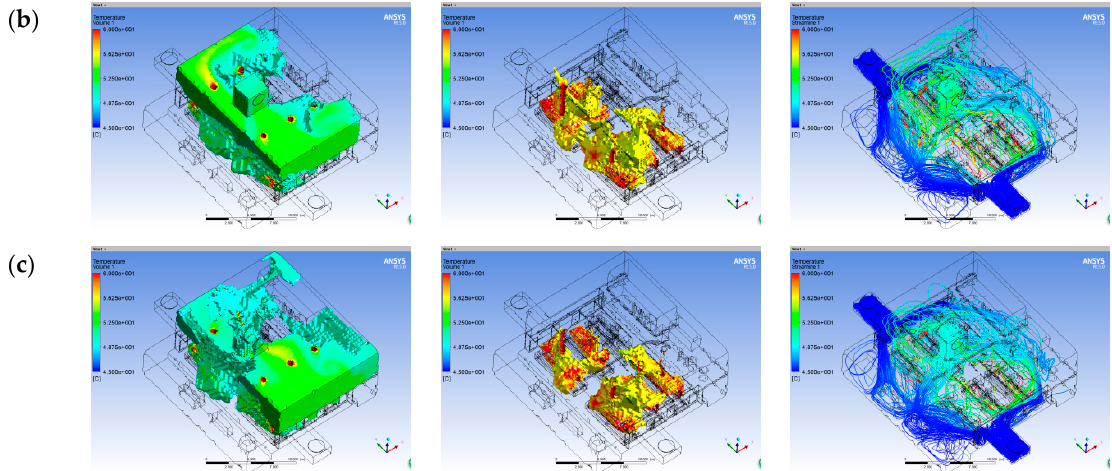
Figure 7. High-temperature volumes above 50 and 55 °C, and temperature streamlines between 45 and 60 °C in the conditions of ( a ) ventilation temperature 45 °C with 0.75 nominal ventilation volume, ( b ) 45 °C with nominal volume, and ( c ) 45 °C with 1.25 nominal volume.